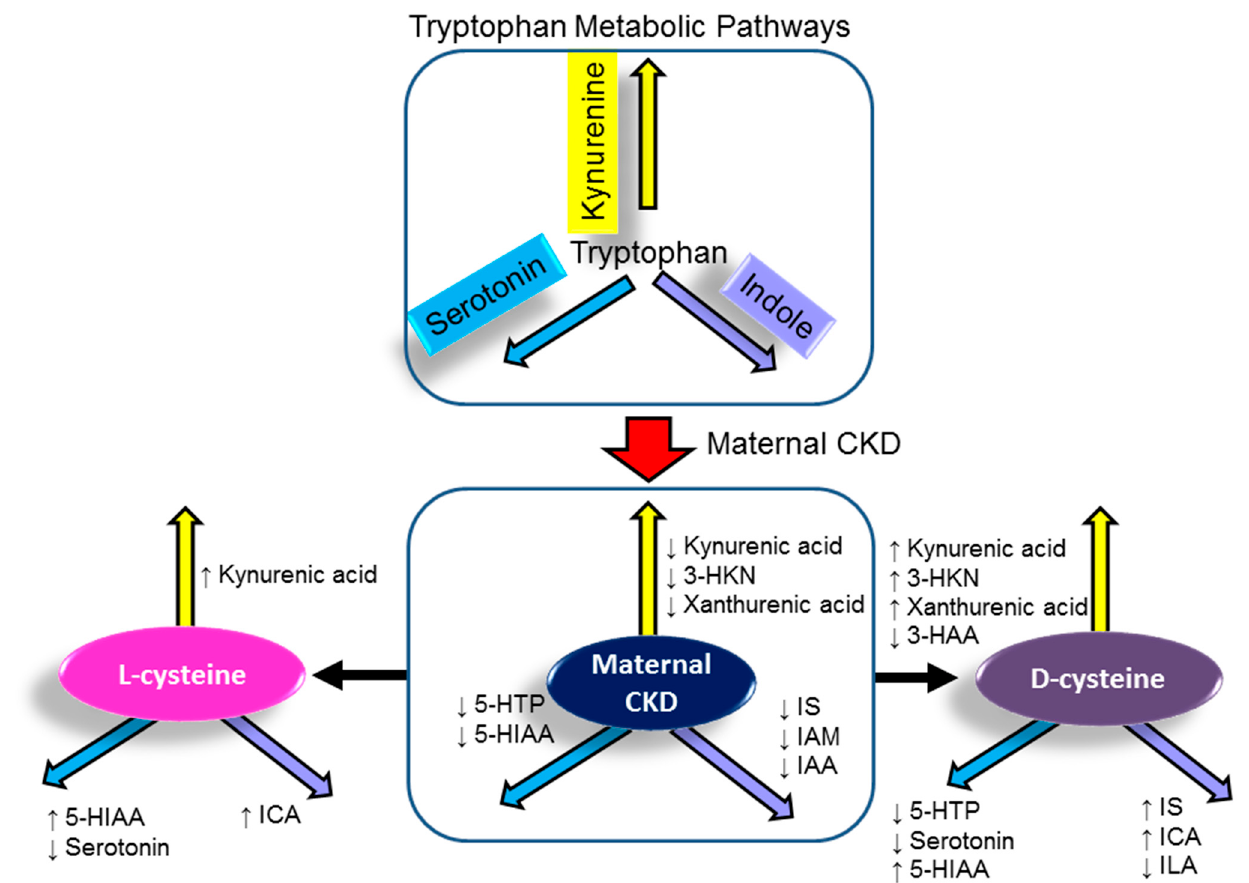
Figure 3. Effect of maternal chronic kidney disease (CKD), L -cysteine, and D -cysteine on major tryptophan-derived metabolites. ↑ = increase; ↓ = decrease. 3-HKN = 3-hydroxykynurenine; 3-HAA = 3-hydroxyanthranilic acid; 5-HTP = 5-hydroxytryptophan; 5-HIAA = 5-hydroxyindole acetic acid; IS = Indoxyl sulfate; IAM = Indole-3-acetamide; ILA = indolelactic acid; ICA = Indole-3-carboxaldehyde; IAA = indoleacetic acid.